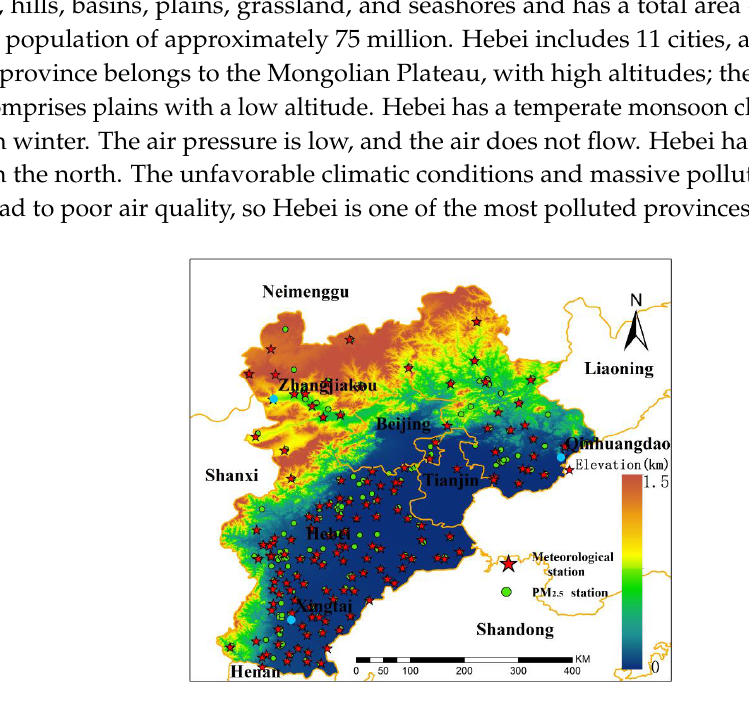
Figure 1. Study region with environmental monitoring stations and meteorological stations.